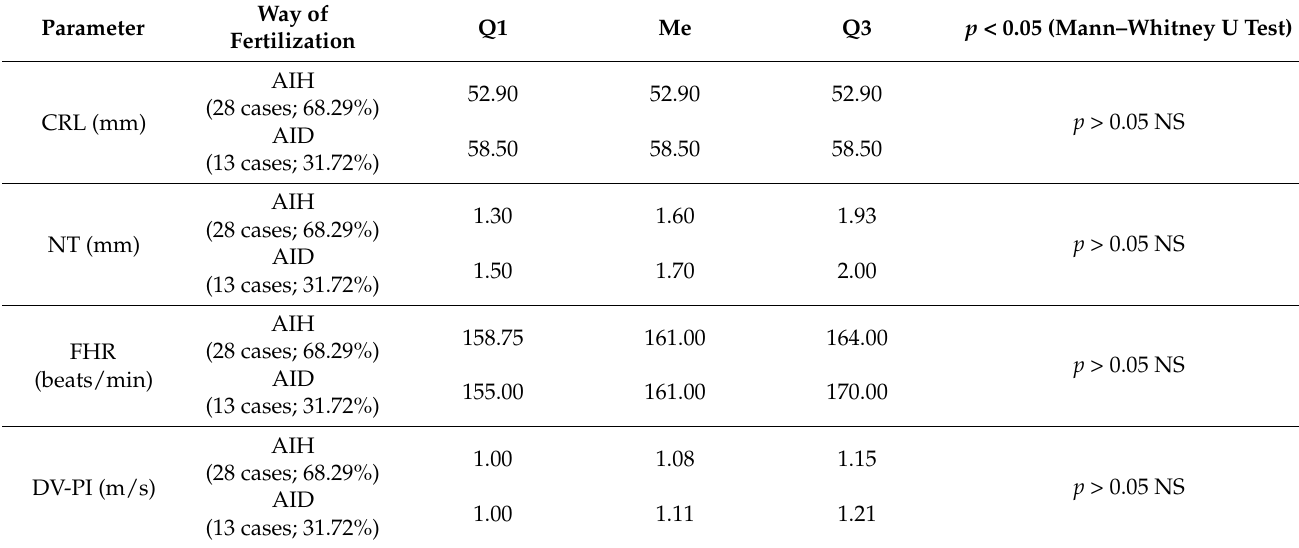
Table 7. Assessment of parameters describing the growth and health of fetuses based on ultrasound examination in a group of women who became pregnant after the induction of ovulation as a result of intrauterine insemination with the sperm of the husband/partner or